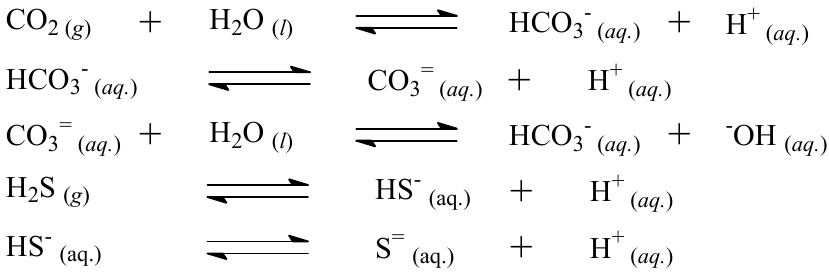
Figure 2. Gas chromatography (GC) ( A ) nondomestic wastewater (WW), ( B ) the treated wastewater (TWW) obtained through HPFD, ( C ) the TWW obtained through CLLE DCM , and ( D ) a raffinate (partially treated water) produced through CLLE DCM –HPFD of the nondomestic wastewater (WW). Markers: n-alkanes, pristine, and phytane.